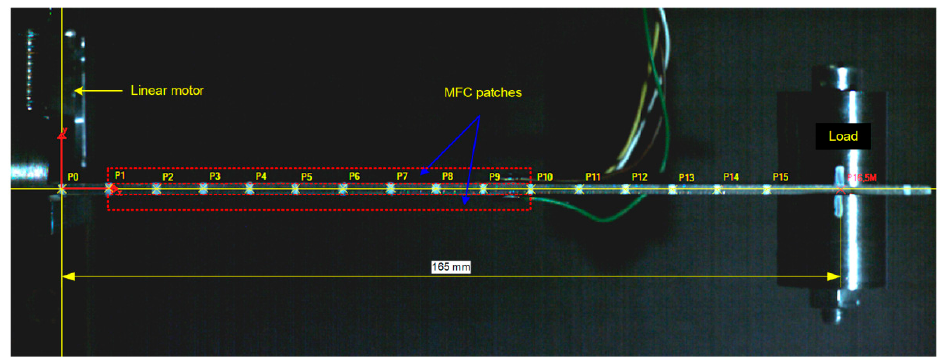
Figure 4. Arrangement of measured points in the cantilever beam structure.